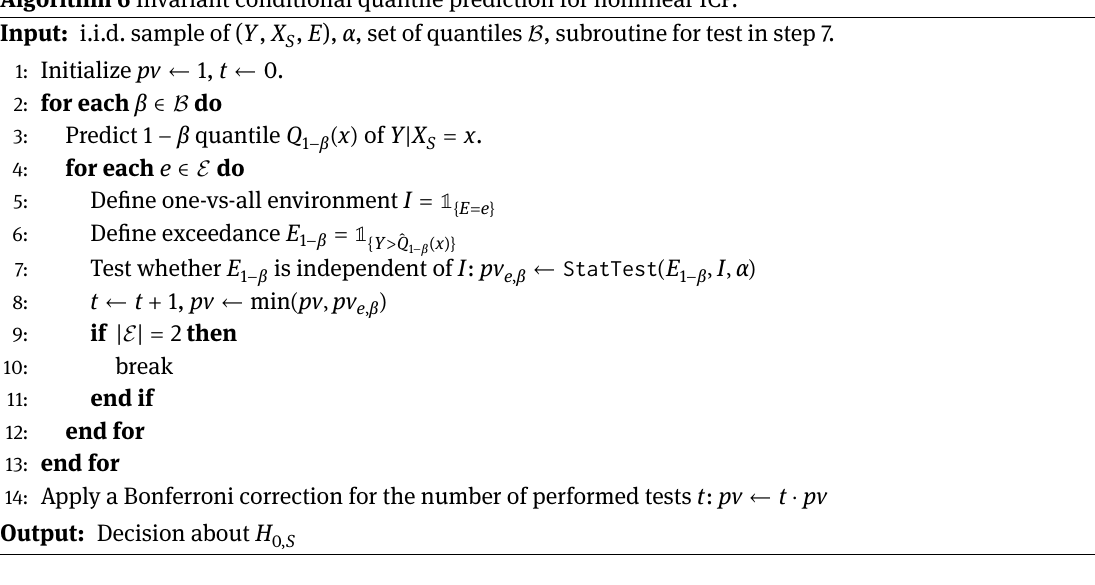
Algorithm 6 Invariant conditional quantile prediction for nonlinear